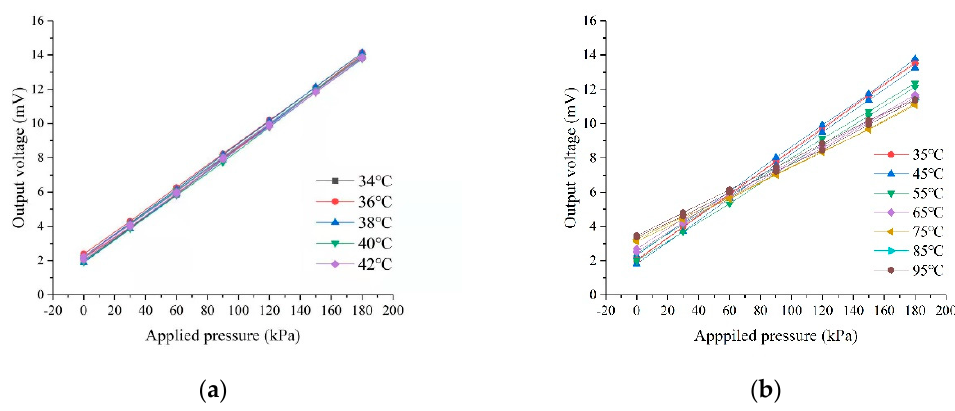
Figure 7. Output voltage for different temperatures. ( a ) for the human body temperature range. ( b ) for temperature range from 25 to 95 °C.